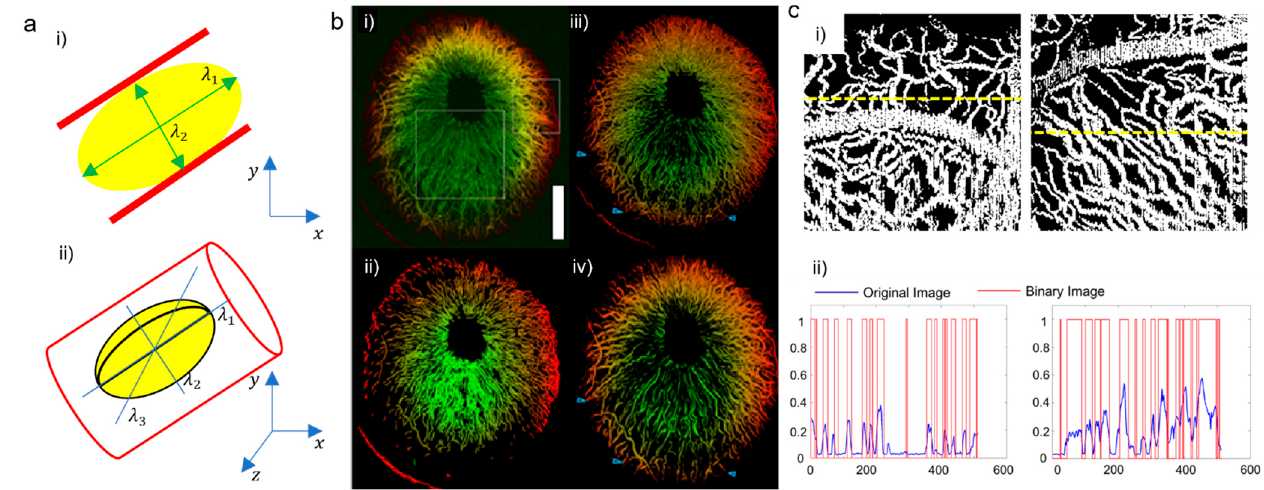
Figure 2. ( a ) Vessel boundary (red) information obtained using the multiscale Hessian-based segmentation algorithm in (i) 2D ( λ 1 , λ 2 ) image and (ii) 3D ( λ 1 , λ 2 , λ 3 ) volume; ( b ) the rat’s iris in (i) the original photoacoustic microangiography, (ii) Hessian segmentation using the 2D MAP image, (iii) 3D volume results of clinical CT-Hessian segmentation, and (iv) 3D volume results of Hessian segmentation using PAM-modified algorithm; ( c ) comparison of (i) the intensity with (ii) the extracted vessel profile. Reproduced with permission from Zhao et al. [81]; published by J. Biomed. Opt. , 2018